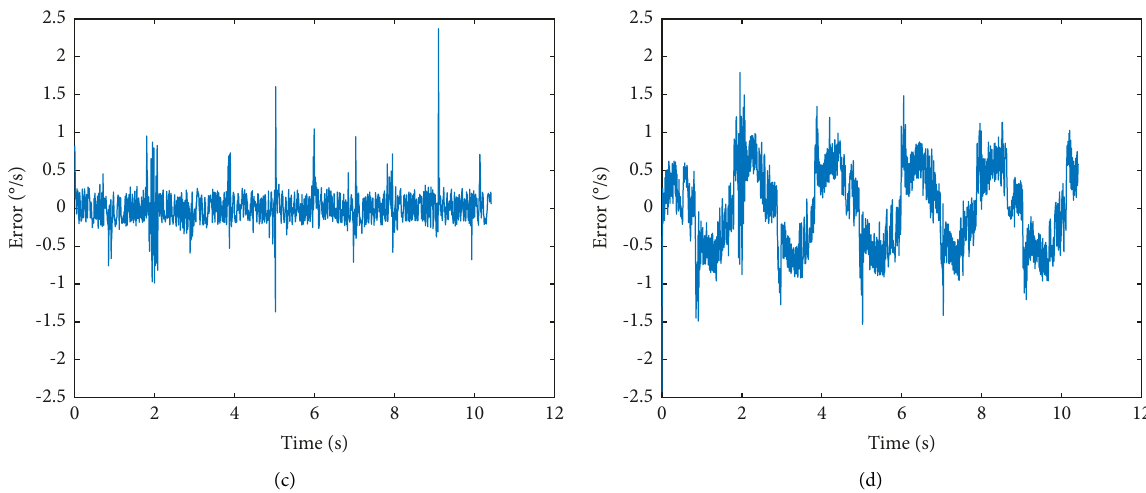
Figure 7: Simulation results under 180 ° /s. (a) Elbow joint torque. (b) Comparison between reference speed, speed response of the FOFPID controller, and speed response of the PID controller. (c) Error between reference speed and speed response of the FOFPID controller. (d) Error between reference speed and speed response of the PID